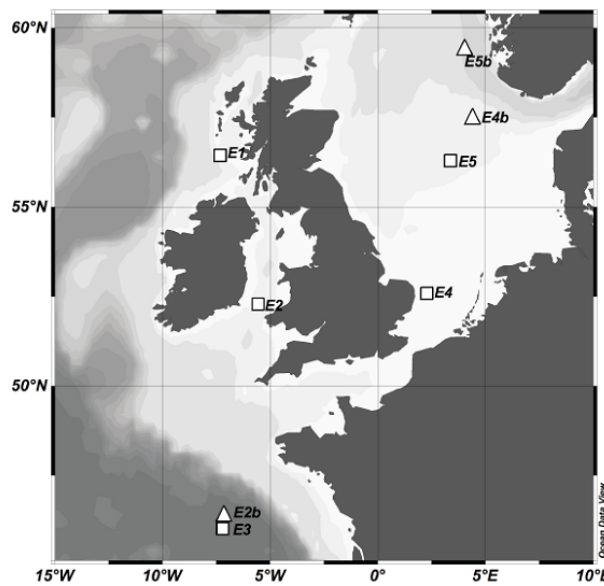
Figure 1. Locations of the main (E1–E5) (square) and the additional (E2b, E4b and E5b) (triangle) bioassay experiments performed dur- ing D366 cruise around NW European continental shelf